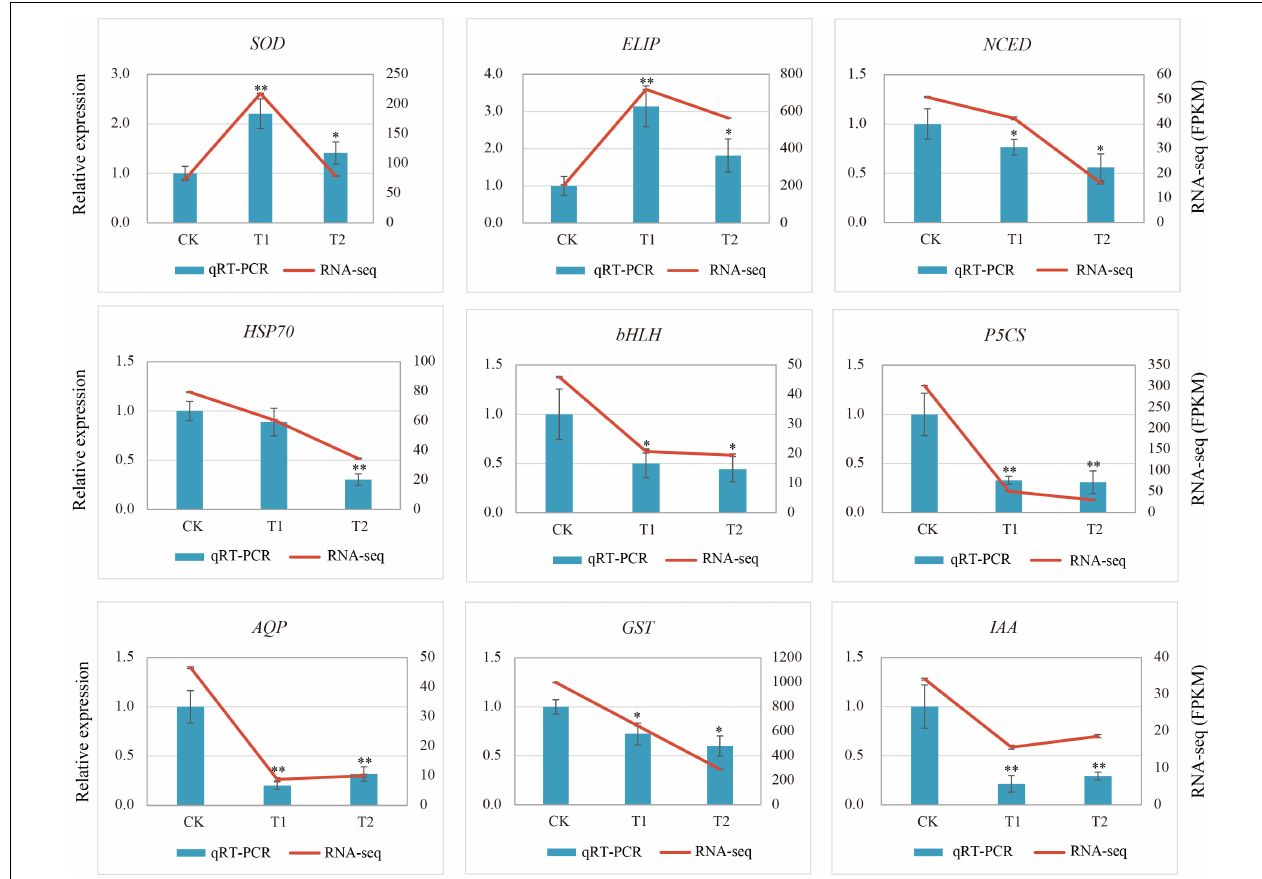
FIGURE 7 | Relative gene expression of nine differentially expressed genes (DEGs) in response to drought stress. Vertical bar charts with error bars (left y-axis) represent the quantification results of nine DEGs using RT-qPCR, and the values are means ± SE ( n = 3). Line graphs (right y-axis) represent the transcript abundance (FPKM) of each gene detected by RNA-Seq. Asterisks ( ∗ or ∗∗ ) represent the significant differences at p < 0.05 or p < 0.01 when compared with the control, respectively.